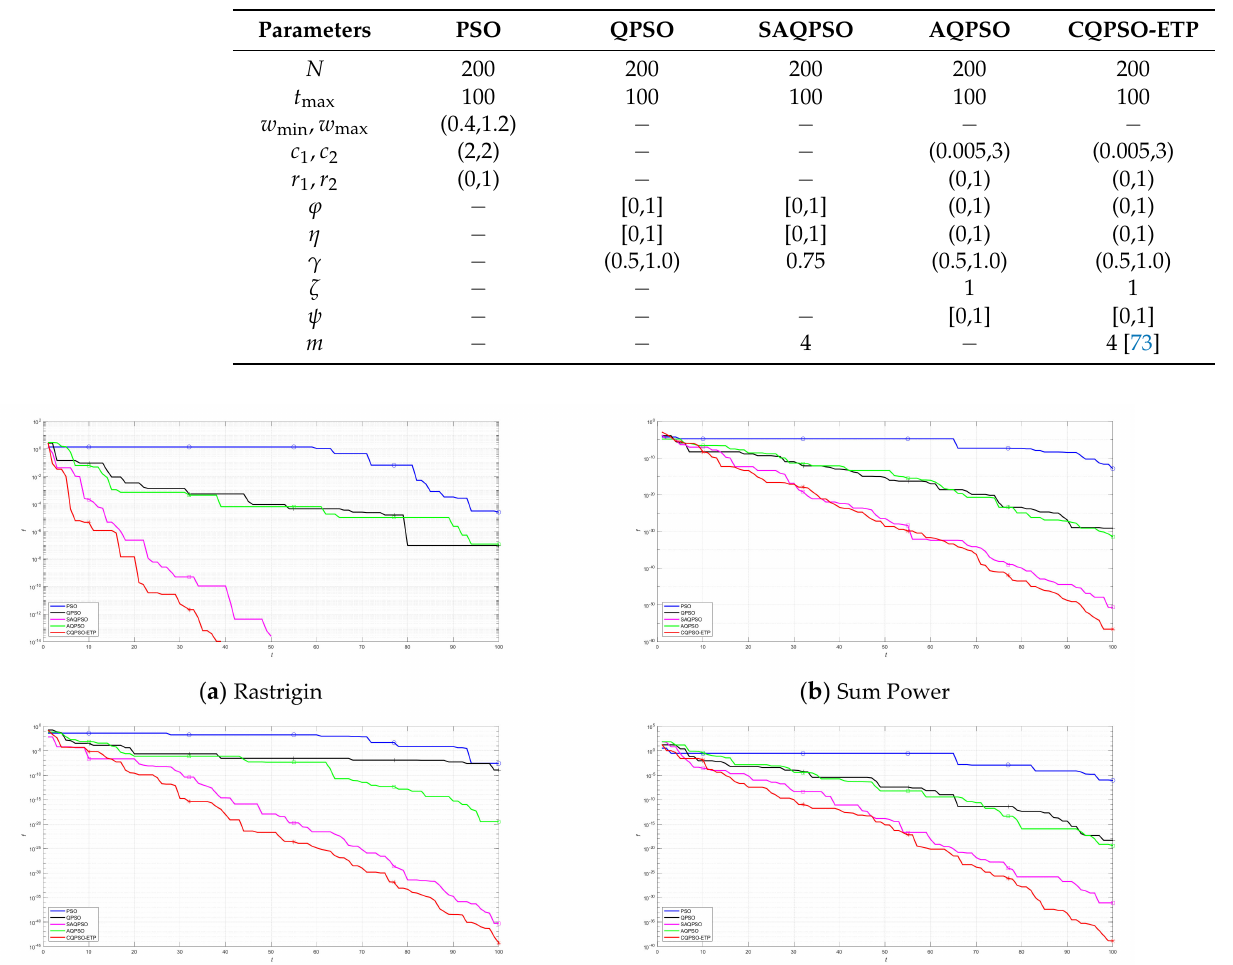
Table 2. Parameter settings in the experiment.